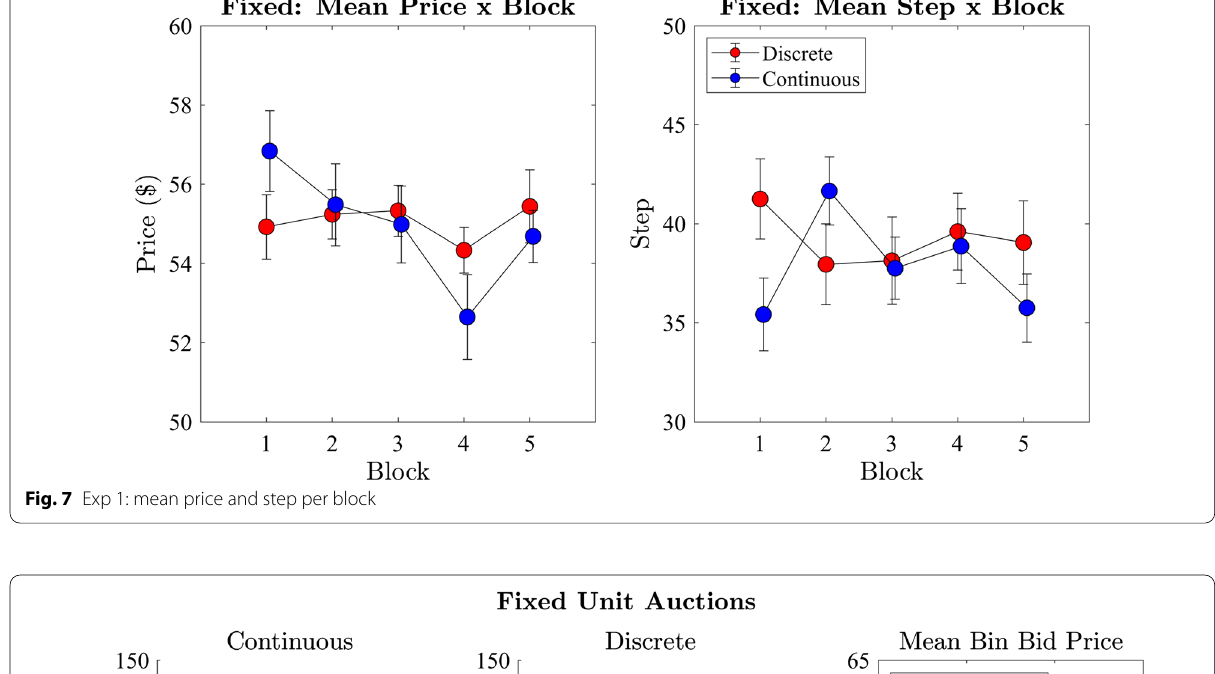
Fig. 7 Exp 1: mean price and step per block